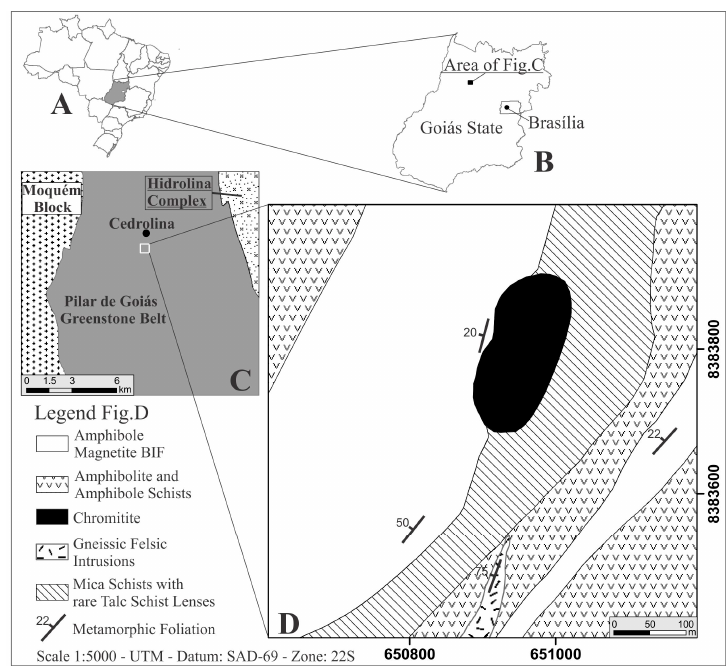
Figure 1. Geological sketch maps of Cedrolina chromitites ( A , B )—Geographical location of the studied area; ( C )—General geology of the central-northern Pilar de Goiás greenstone belt area simplified after [23]; ( D )—Detailed geological map of a small portion of the Cedrolina Formation where the investigated chromitites occur [20].